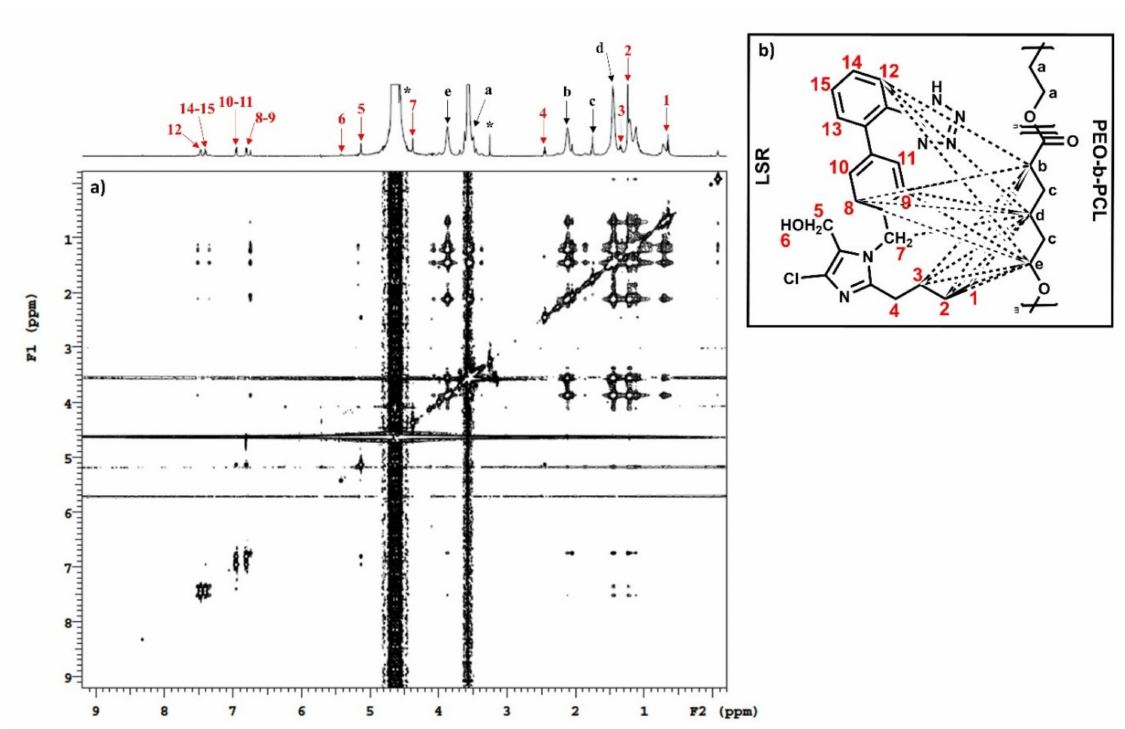
Figure 9. ( a ) 2D-NOESY spectrum of PEO-b-PCL + 50% LSR nanocarriers and ( b ) schematic approach of LSR in PEO-b-PCL micelles. The black letters (a–e) denote the protons of the copolymer structure, the red letters point to the LSR peaks and the asterisk refers to the solvent D 2